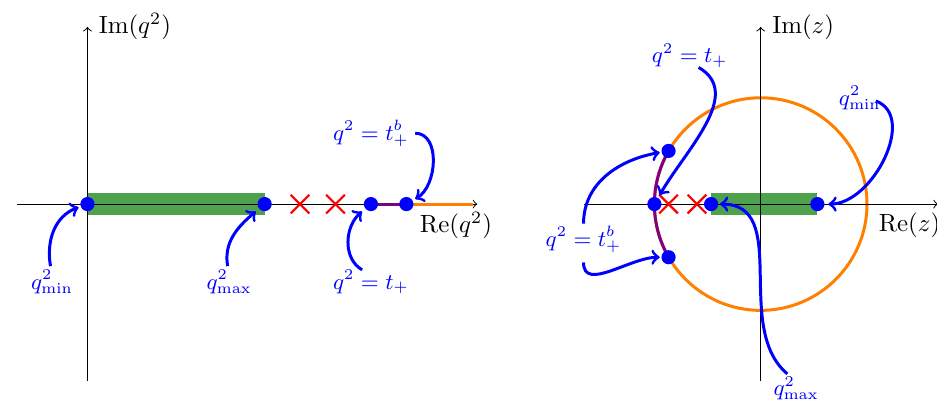
Figure 1 . Illustration of the complex q 2 and z plane. The green region represents the semileptonic region, the red crosses possible sub-threshold resonances, and the orange contours the branch cut. The purple line(arc) in the left(right) panel arises from t + 6 = t b q 2 points.